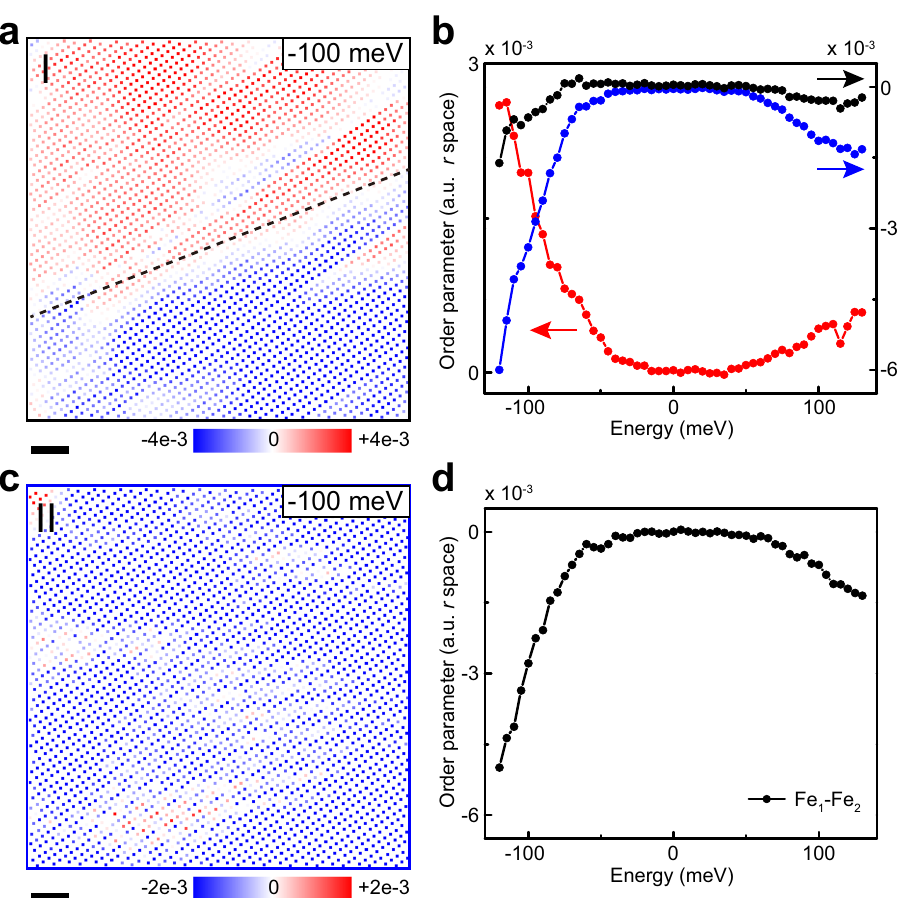
Fig. 4 [110] Electronic order measured at liquid helium temperature. a Local [110] electronic order on the left side of the twin boundary (scale bar: 2 nm). The black dashed line highlights the boundary of the domains with different signs. b The red and blue curves are collective orders for the red and blue areas in a , respectively. The black curve is the collective order over the area of a . c Local [110] electronic order on the right side of the twin boundary (scale bar: 2 nm). d The collective order on the right side of the twin